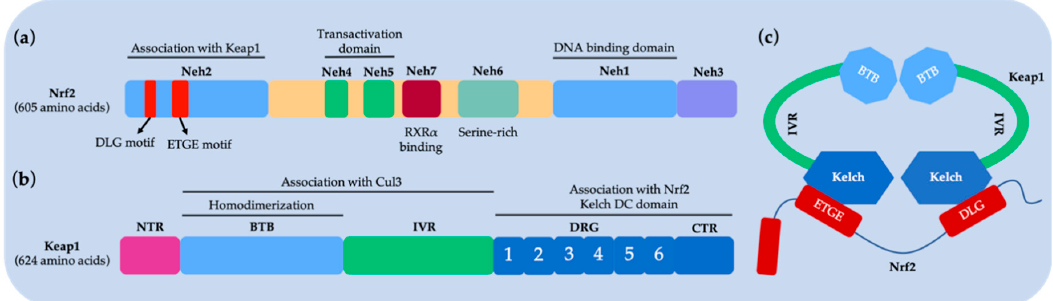
Figure 1. Schematic diagram of Nrf2 and Keap1 domains. ( a ) Nrf2 comprises seven major domains,